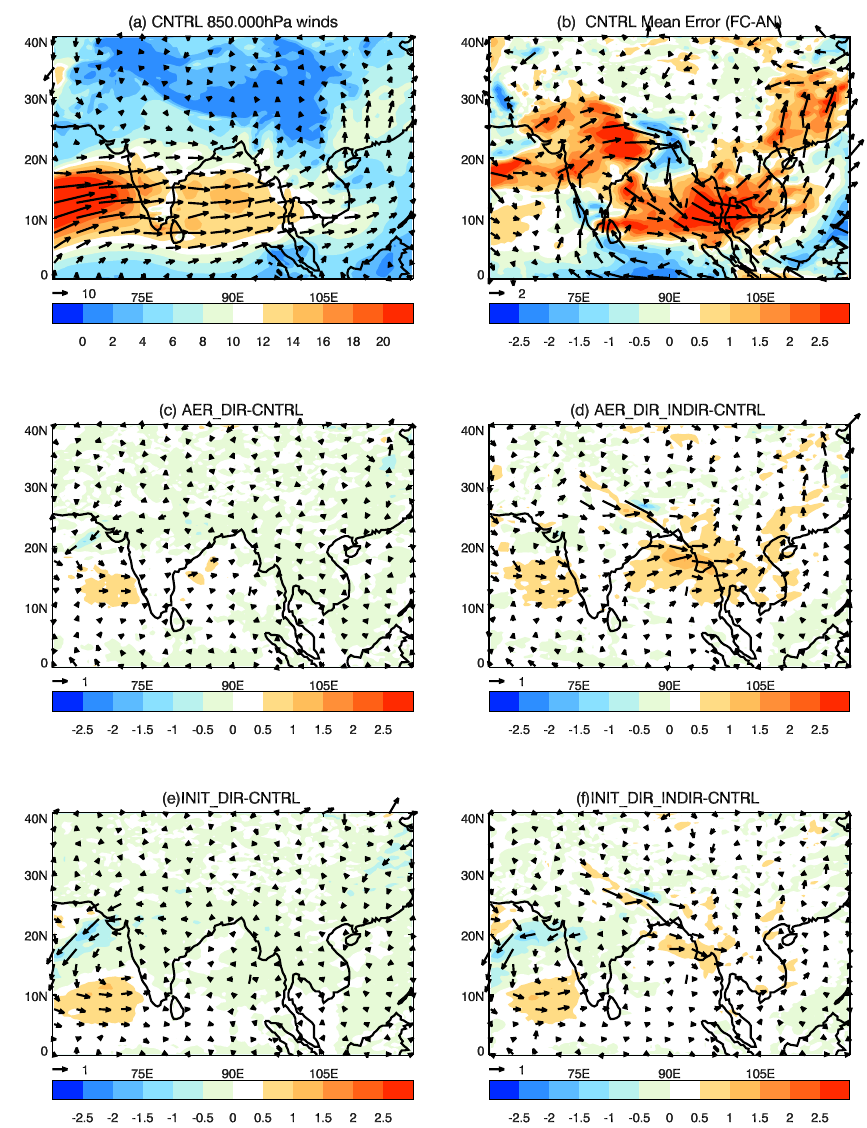
Fig. 18. Impact on 850hPa winds over South Asia at T + 120: (a) CNTRL wind fields, (b) CNTRL error, (c) AER_DIR-CNTRL, (d) AER_DIR_INDIR-CNTRL, (e) INIT_DIR-CNRTL, (f)